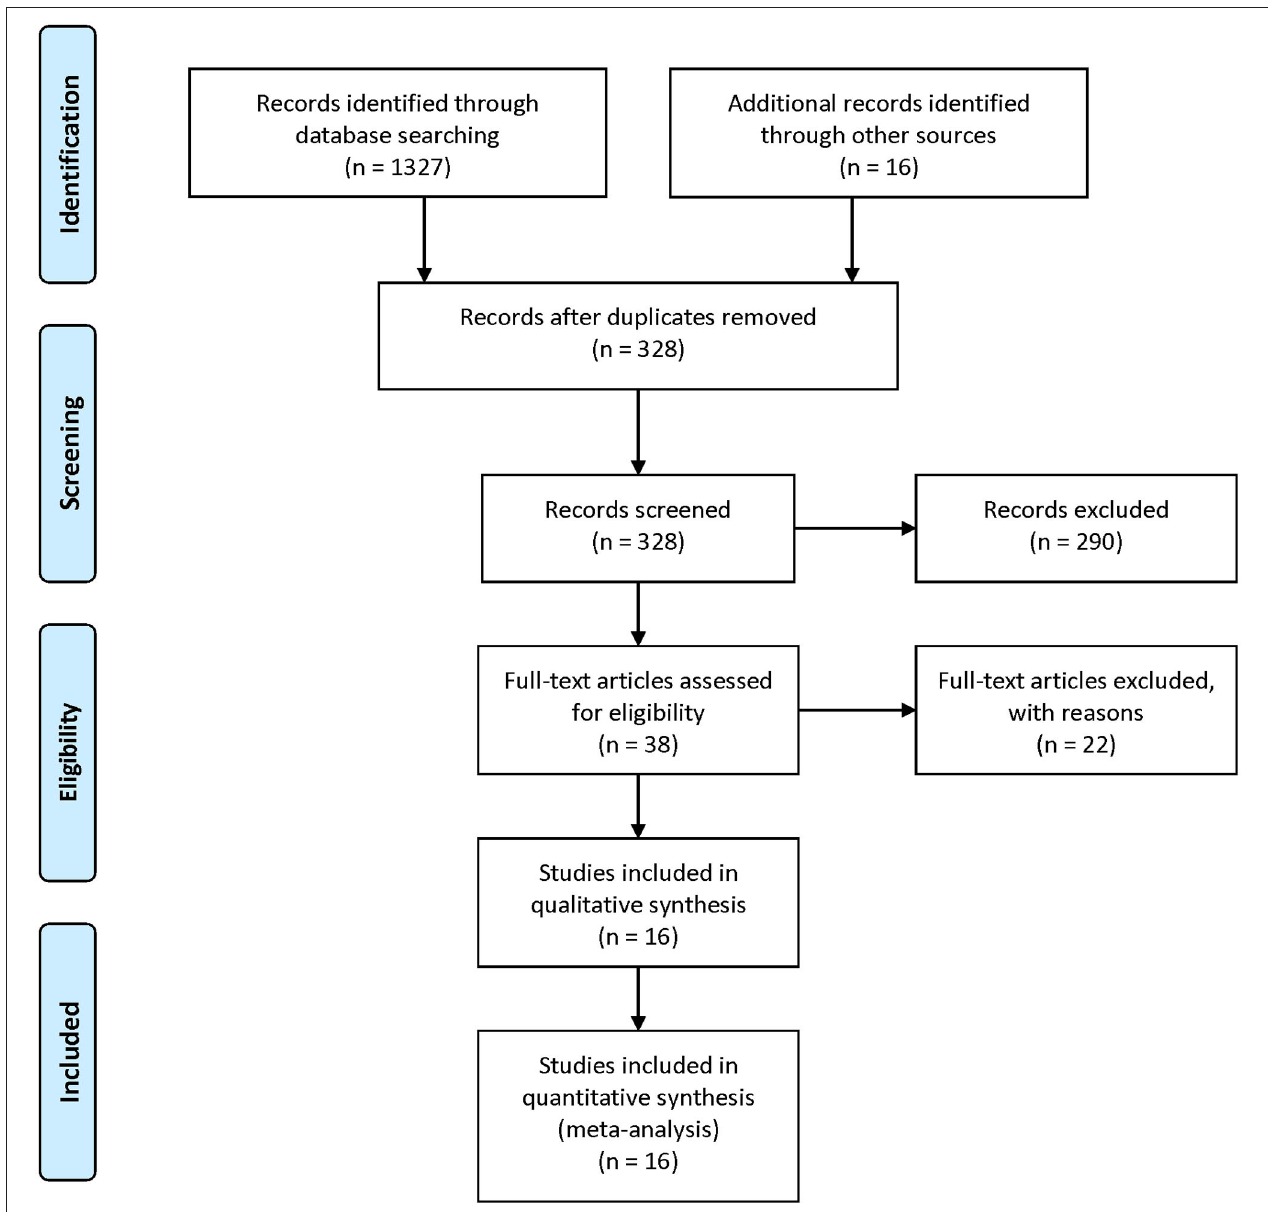
FIGURE 1 | PRISMA Flow-diagram depicting identification and selection process for the present